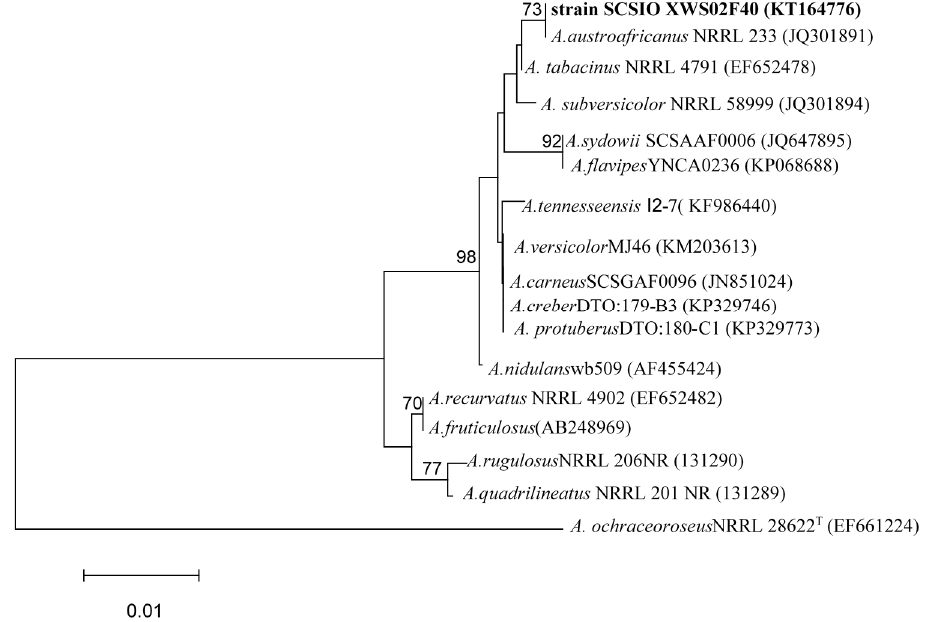
Figure 6. The neighbor-joining tree based on ITS1-5.8S-ITS2 sequences, showing a phylogenetic relationship between strain SCSIO XWS02F40 and related Aspergillus species. Only boot strap values >70% are shown. GenBank accession numbers are given in parentheses . Bar: 1% sequence divergence.